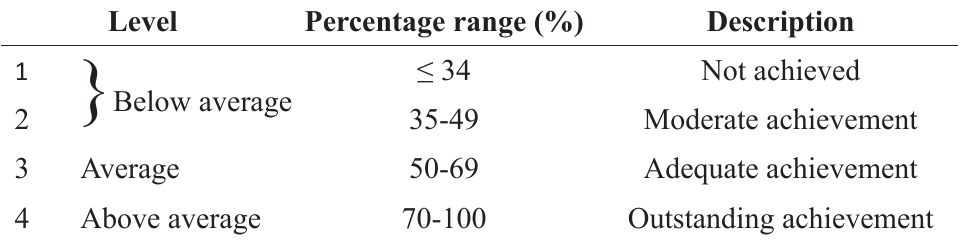
Table 2. Levels of assessment used for Grade 4–5 learners by the Department of Education.